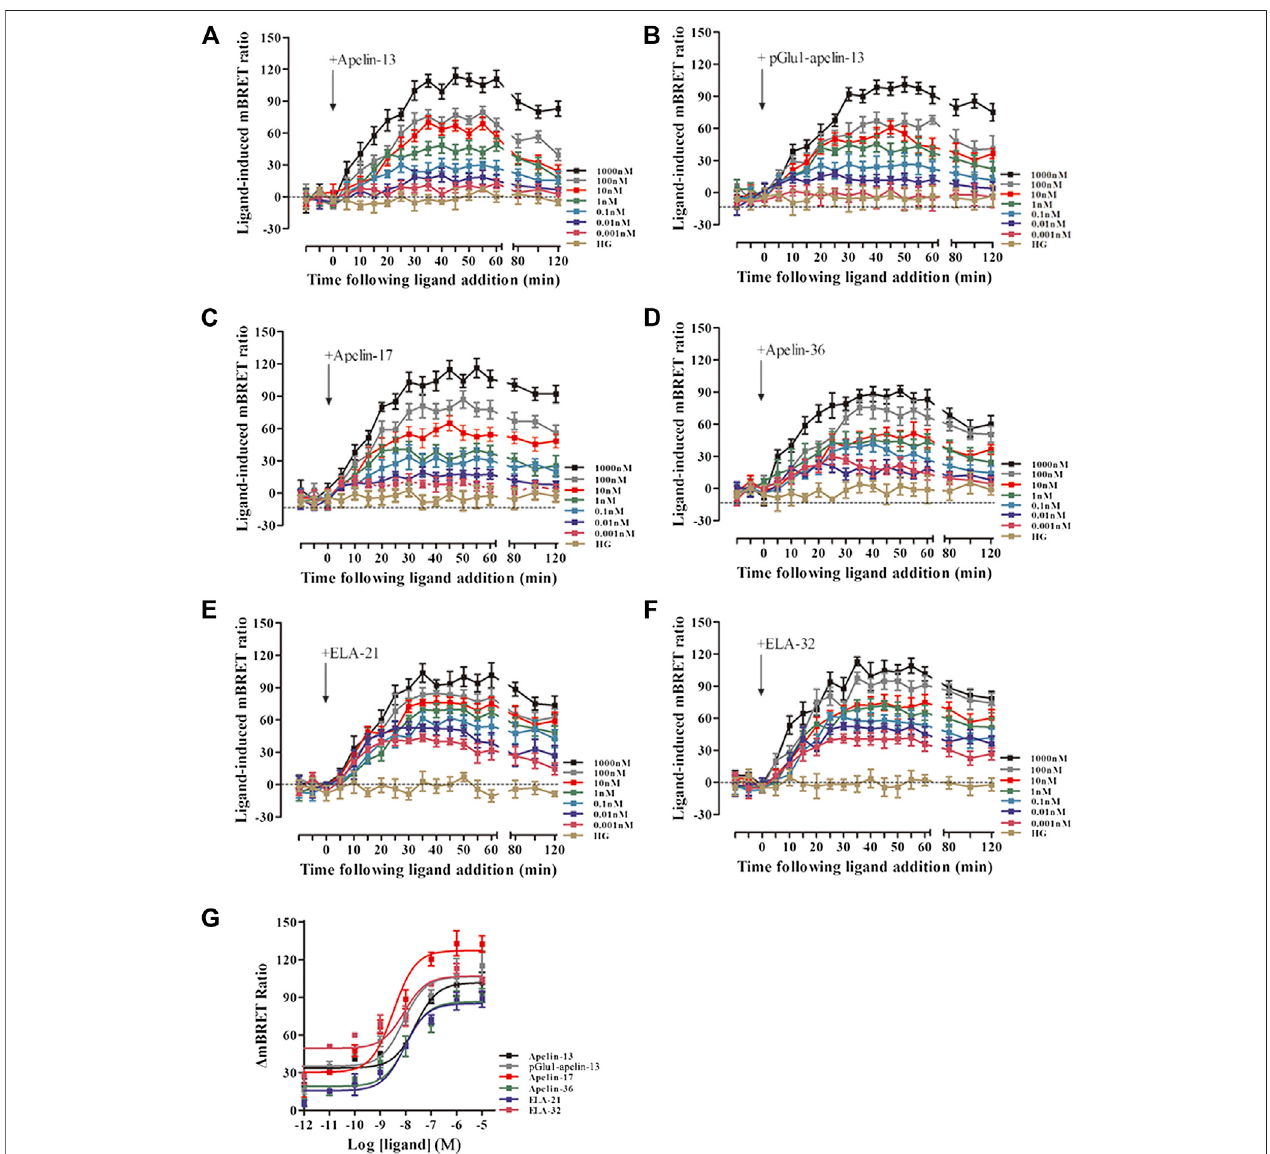
FIGURE 8 | The time-response curve (A – F) and dose-response curve (G) of interactions between β -arrestin1 and AP2 induced by APJ upon activation by the six agonists in different concentrations, obtained from real-time dynamic BRET determination. p < 0.05 was considered as statistically signi fi cant. Control group (HG, Cells were stimulated with high glucose). The BRET assay to measure the six peptide (0.001 – 1,000 nM) induced concentration-response curves of β -arrestin 1 and β 2- adaptinrecruitmenttoAPJat30 minpost-stimulation (G) .Thedatarepresentmeans ± SEMoffourindependentexperiments.Statisticalanalysis( Supplementary Table S7